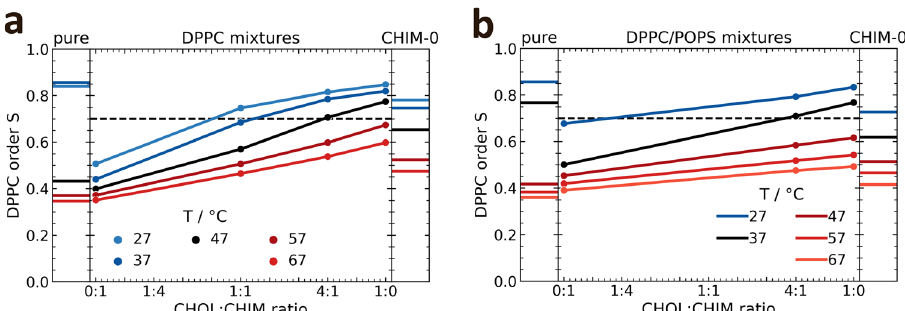
Fig 2 Effect of cholesterol and CHIM on order parameters in DPPC bilayers. Order of DPPC chains in DPPC ( a ) and DPPC/POPS (2:1) ( b ) mixtures containing CHOL, CHIM or a mixture of CHIM/CHOL, respectively, as a function of the cholesterol fraction within a total sterol concentration of 30 ( a ) and 20 ( b ) mol%. For comparison, the order of a pure DPPC bilayer and respective bilayers containing only CHIM-0 (the arbitrary charge-neutral CHIM- analog) is shown in the left and right panels, respectively. The color codes indicate the MD simulation temperatures, separating them in regimes of below (blues), above (reds), and near phase transition (black). The black dashed line is included to better distinguish between an ordered (S > 0.7) and disordered (S <